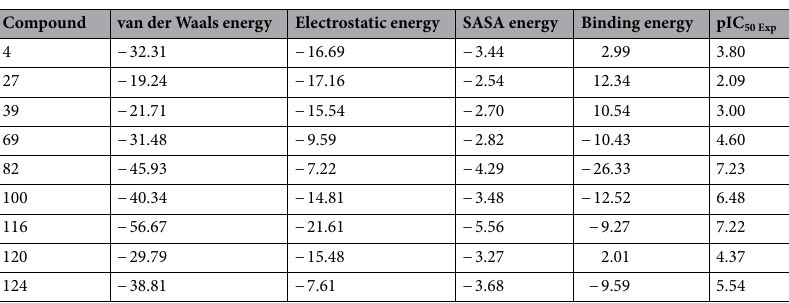
Table 3. van de Walls, electrostatic, SASA, and binding energy (BE) (in kcal/mol) of the studied compounds.